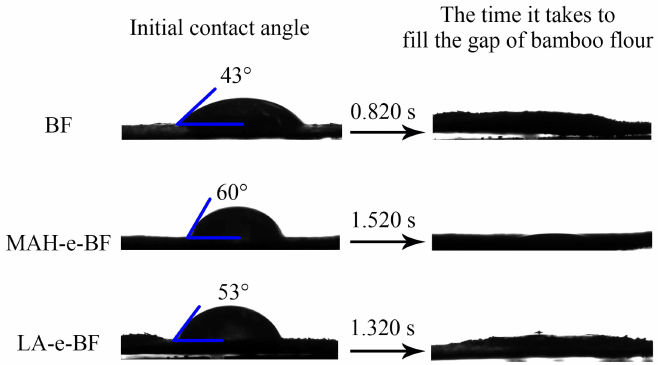
Figure 5. The contact angle of BF, MAH-e-BF, and LA-e-BF.